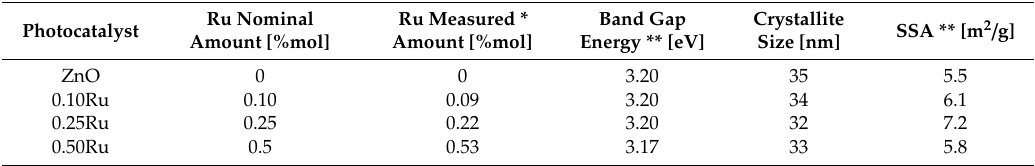
Figure 1. XRD spectra of undoped ZnO and Ru-modified ZnO photocatalysts in the range 20–80 ◦ . Table 2. The chemical-physical characteristics of the prepared